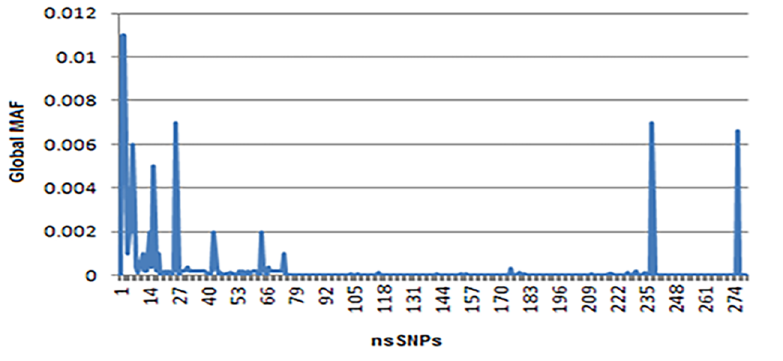
Fig 2. Graphical representation of global MAFs of